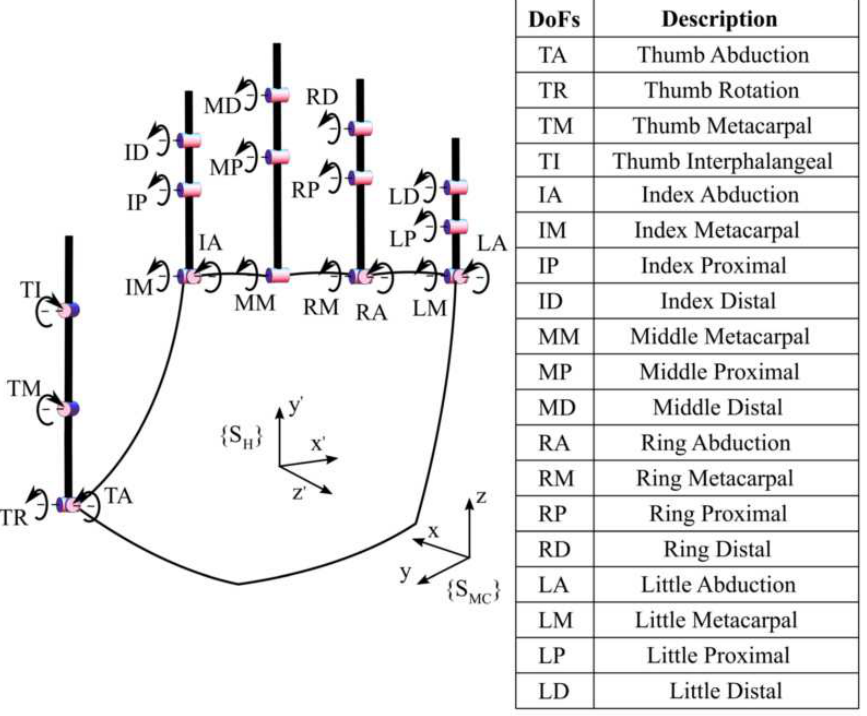
Figure 2. Kinematic model of the hand with 19